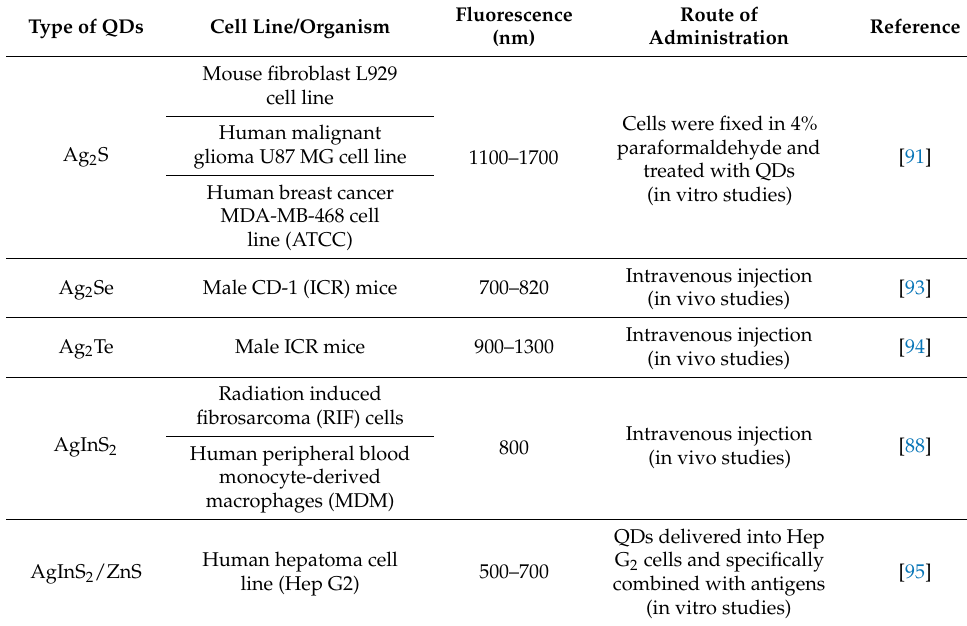
Table 5. In vitro and in vivo assays for bioimaging of Ag-based